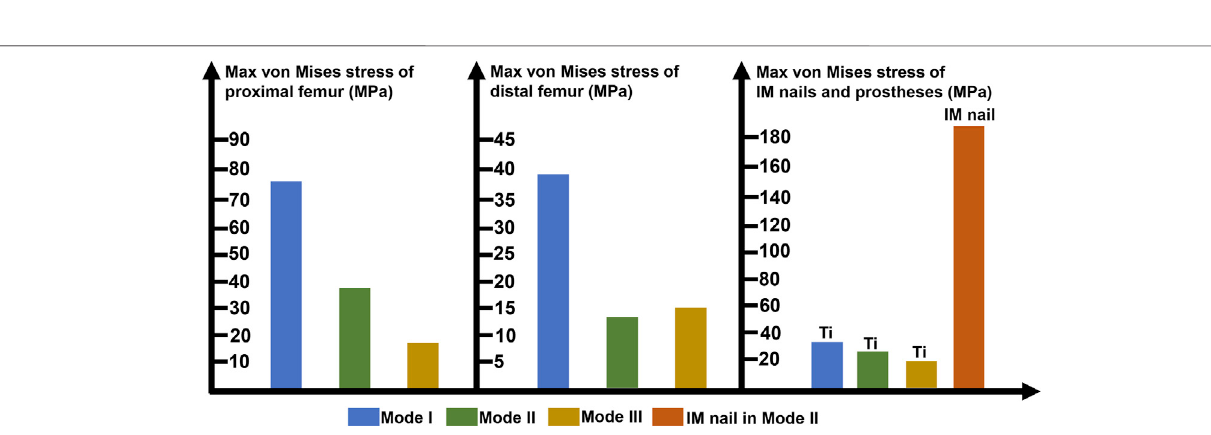
Frontiers in Bioengineering and Biotechnology |